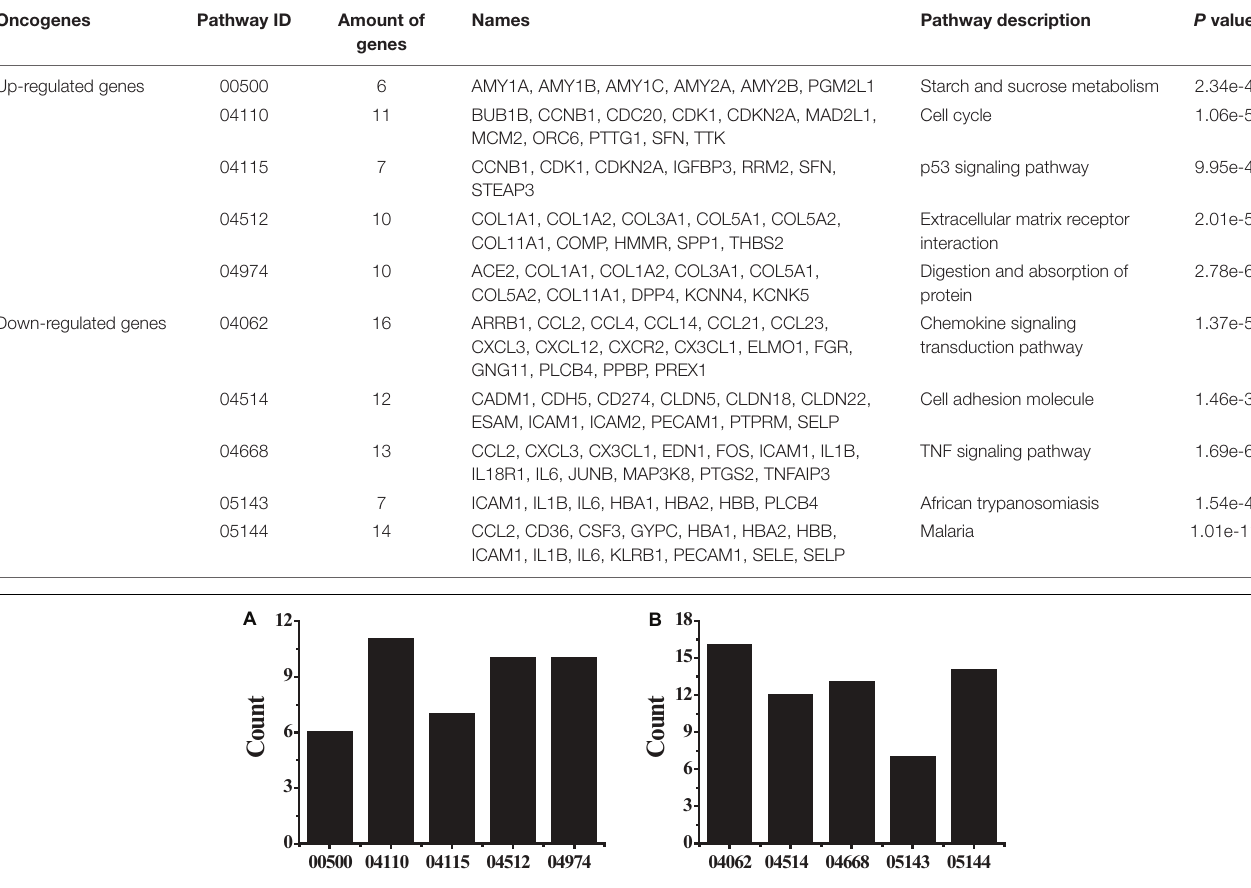
TABLE 4 | The KEGG pathway analysis results of differently expressed up-regulated genes and differently expressed down-regulated genes. Oncogenes Pathway ID Amount of genes